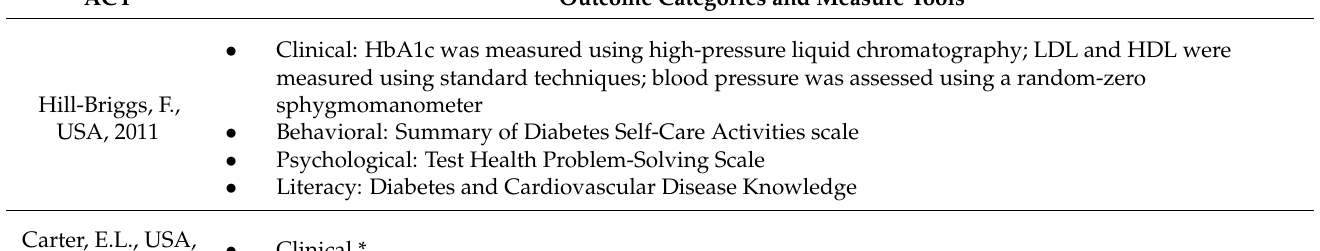
Table 3. Cont . Outcome Categories and Measure